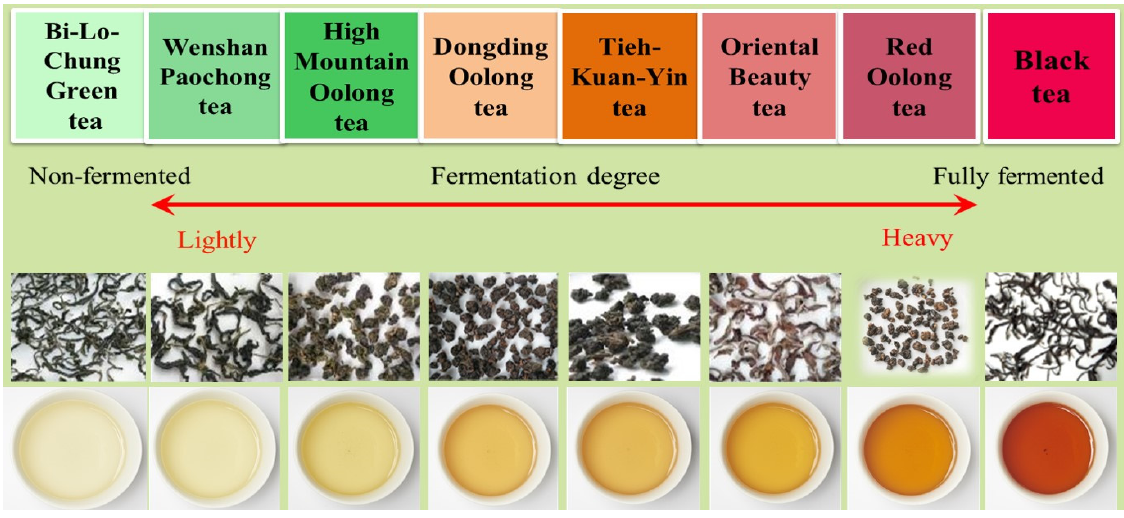
Figure 3. The eight specialty teas in Taiwan were characterized by their fermentation degree, shape, and infusion color. Taiwan is the main producing area of partially fermented Oolong tea in the world [27], so the Oolong teas are more diverse, and the flavor spectrum is broader than that of green or black tea. Oriental Beauty tea is famous for its organic production and unique